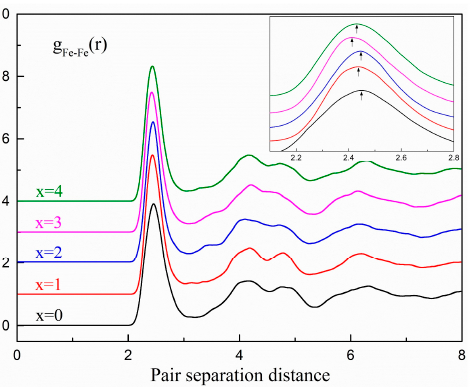
Figure 2. Partial PDFs for Fe-Fe pairs in the Fe 80+x Si 5-x B 15 ( x = 0–4) amorphous alloys at 300 K. The insert is the enlarged part of the first peaks. Table 1. Positions of the first peaks for g Fe-Fe (r) at 300 K.